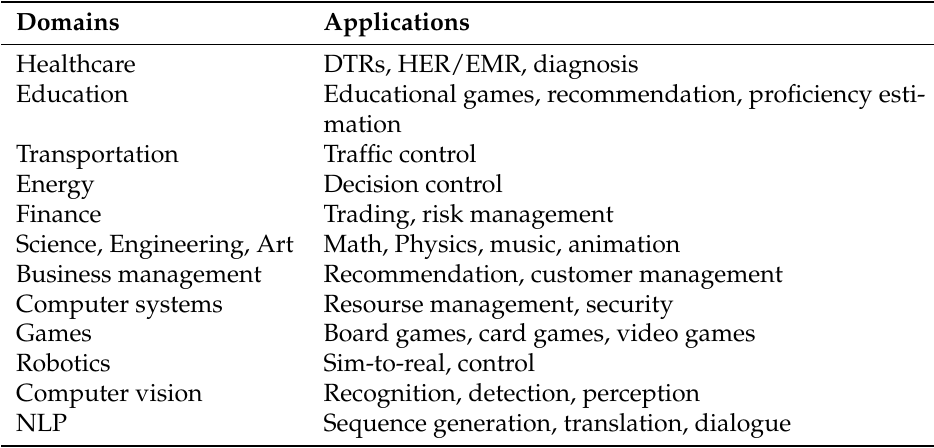
Table 2. Various DRL Applications, summarized from